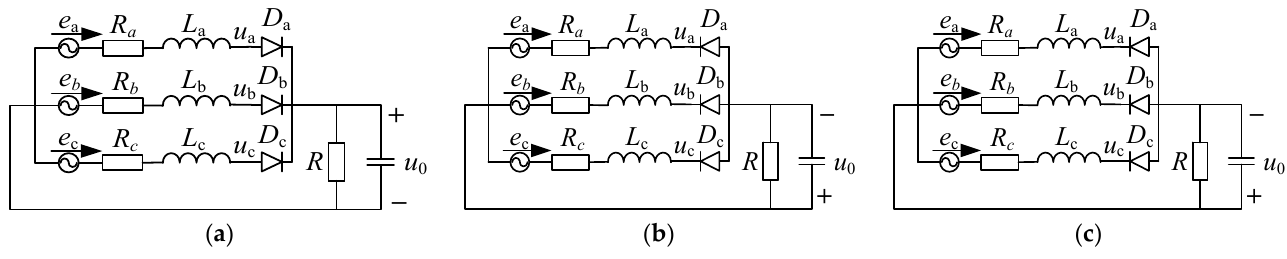
Figure 8. Rectification circuit of three power generation modes: ( a ) SRG mode; ( b ) DSG1 mode; ( c ) DSG2 mode.